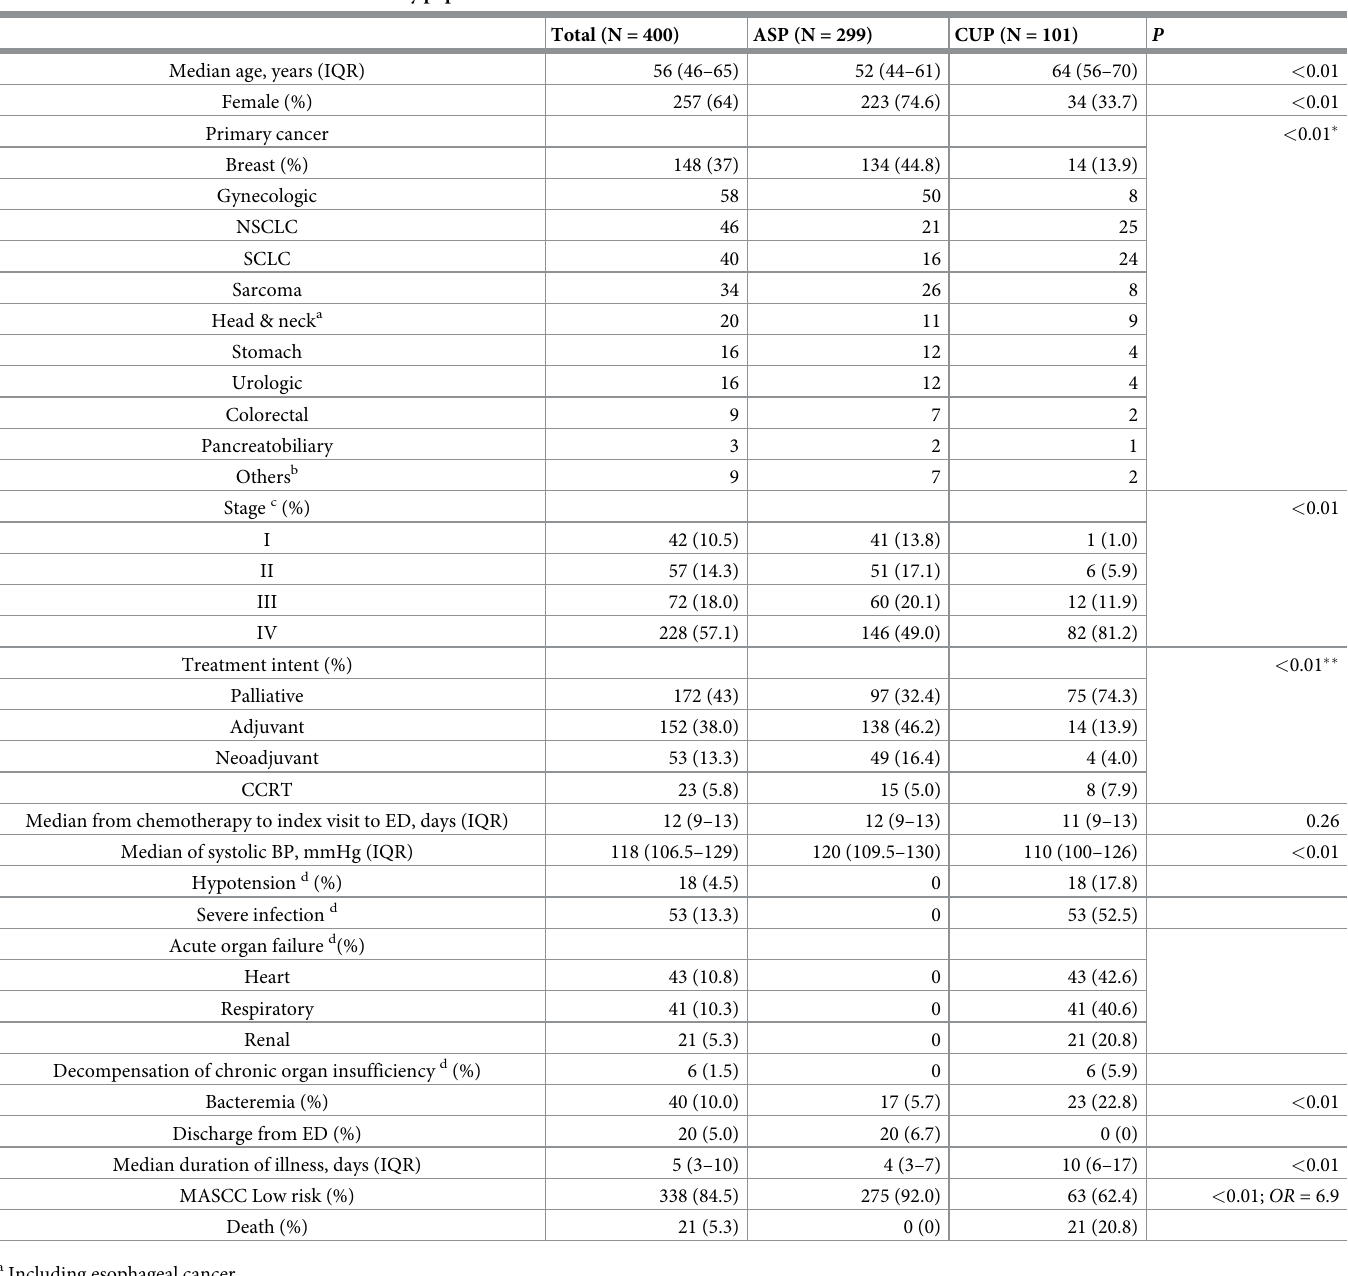
Table 1. Baseline characteristics of the entire study